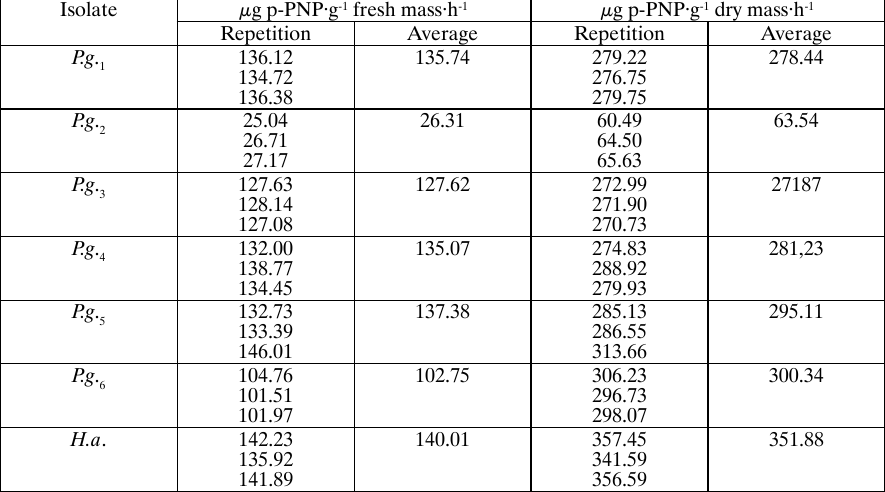
Phosphatase activity of P. gigantea and H. annosum isolates